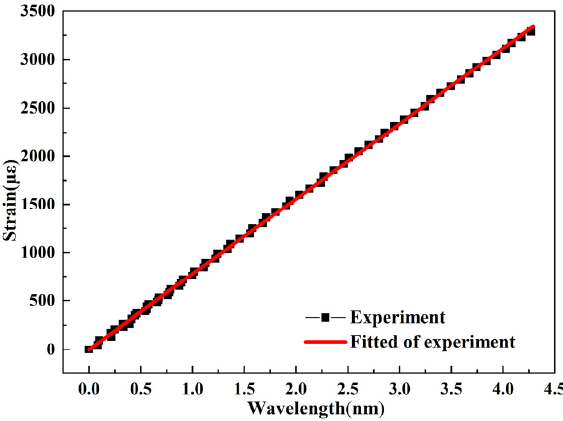
Figure 8. Relationship between strain and wavelength.